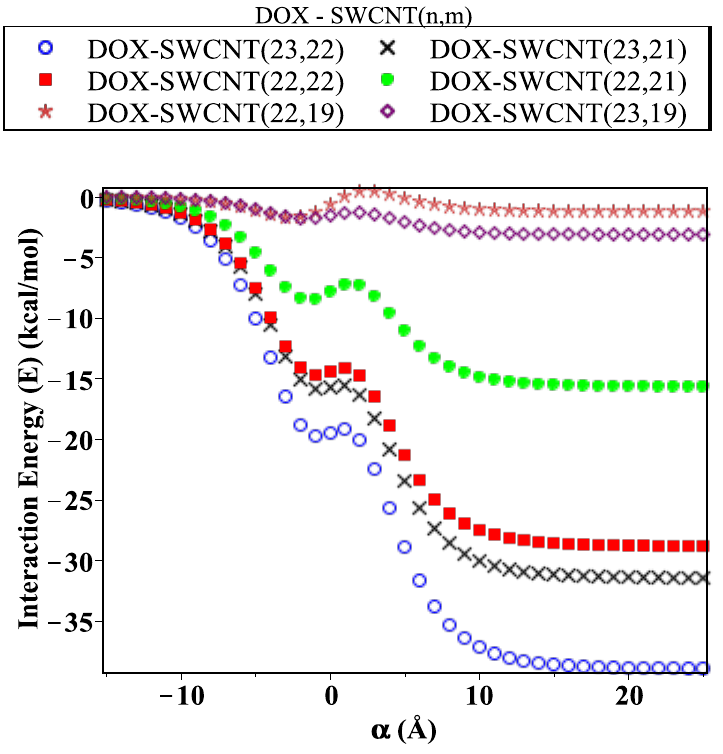
Figure 4. Interaction energy ( E ) arising from DOX molecule interacting with SWCNTs of various radii r .